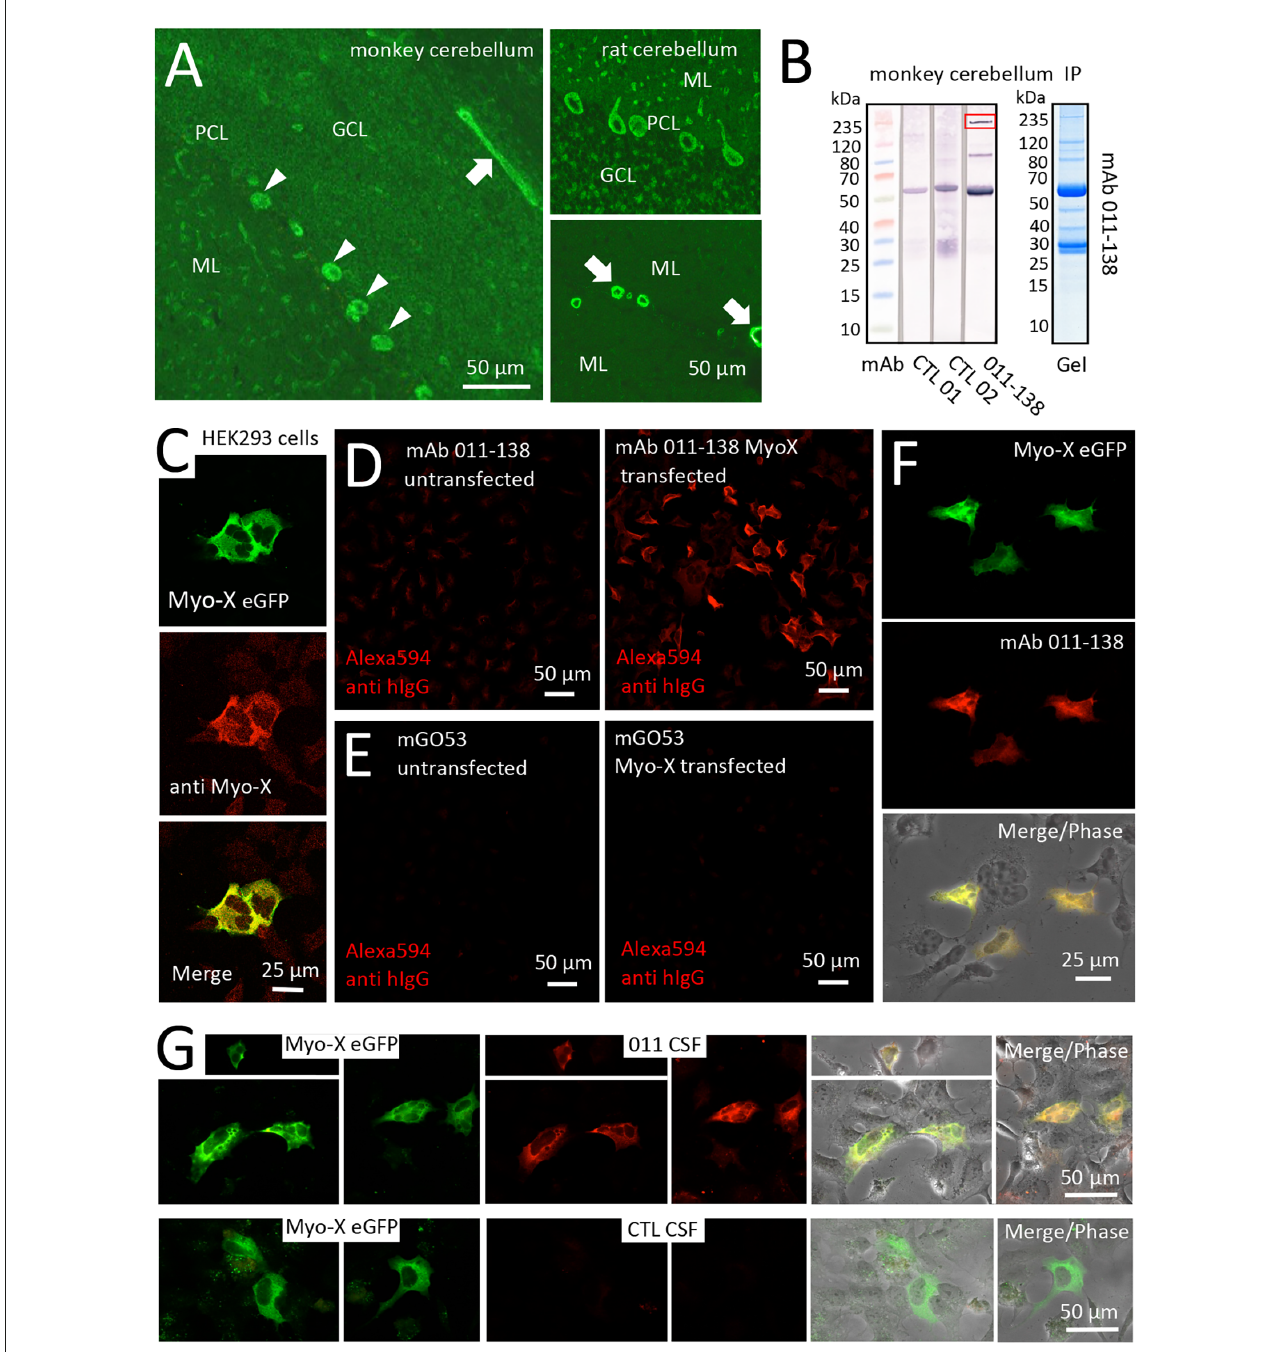
FIGURE5 Antibody 011-138 targets Myosin-X in transfected HEK cells. (A) Monkey and rat brain biochip cryosections (EUROIMMUN AG) were incubated with human monoclonal antibody (mAb) 011-138 (1:100) and exhibited pronounced staining of blood vessels (left panel and lower right panel arrows) and Purkinje cells (left panel arrowheads and upper right panel). (B) Immunoprecipitation analysis using monkey brain lysates. Lysates were incubated with either mAb 011-138 or two other non-vessel reactive human monoclonal antibodies for control. Dynabeads were used to precipitate antibodies together with bound antigens. Elute fractions were again incubated with the precipitating antibody followed by Western blotting. The marked band at 55 kDa in all three lanes presumably resulted from detection of the precipitating heavy chain by the detecting secondary anti-human IgG conjugate. In addition, mAb 011-138 showed two distinct bands at 80 and 240 kDa (boxed), respectively. The corresponding Coomassie gel is shown for mAb 011-138. (C) HEK 293 cells were transfected with an eGFP construct of human Myosin-X (Myo-X) plasmid DNA for 24 h. Expression of Myo-X was verified in fixed cells using a commercial monoclonal anti-Myo-X antibody showing a very high degree of signal overlap (confocal imaging). (D) Incubation of Myo-X-transfected cells with 5 µ g/ml of 011-138 antibody showed binding to fixed transfected cells that were absent in untransfected cells. A secondary anti-human IgG antibody coupled to Alexa594 was used for detection. (E) For negative control untransfected and Myo-X-transfected cells were incubated with 5 µ g/ml of mGo53 antibody. No staining was observed under either condition. (F) In transfected cells incubated with 011-138 antibody the human IgG signal showed a very high degree of overlap with eGFP-Myo-X signal. (G) HEK 293 cells were transfected with an eGFP construct of human Myo-X plasmid DNA for 24 h. Incubation of Myo-X-transfected cells with patient-CSF 011 showed binding that was absent after incubation with control-CSF. The right panel shows a high degree of overlap of patient-CSF 011 signal with eGFP-Myo-X